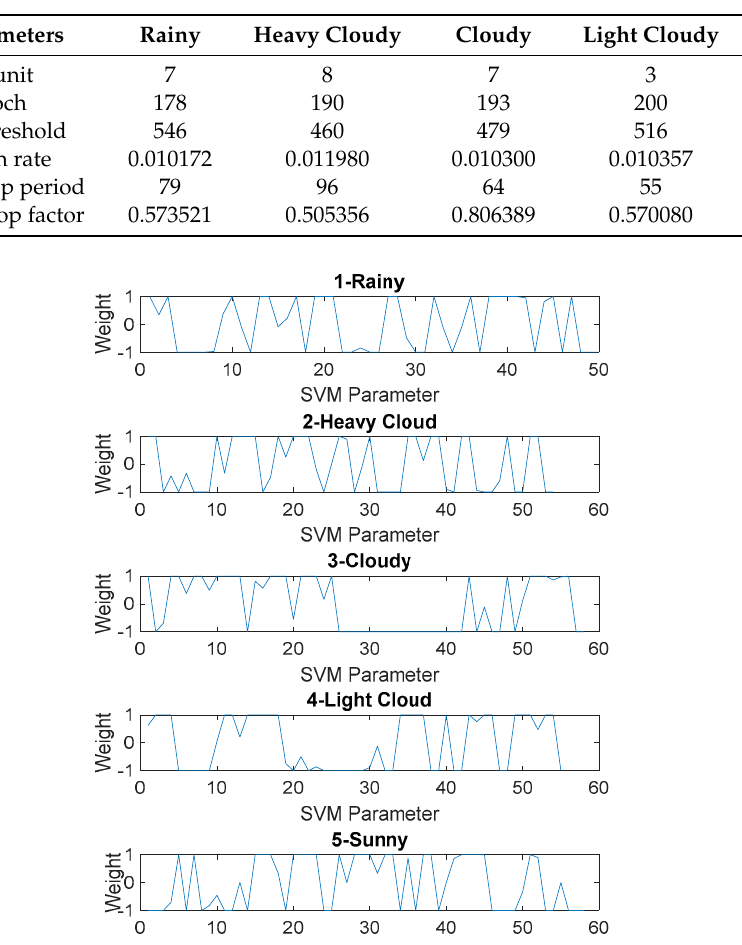
Table 3. The LSTM-SSA parameters.